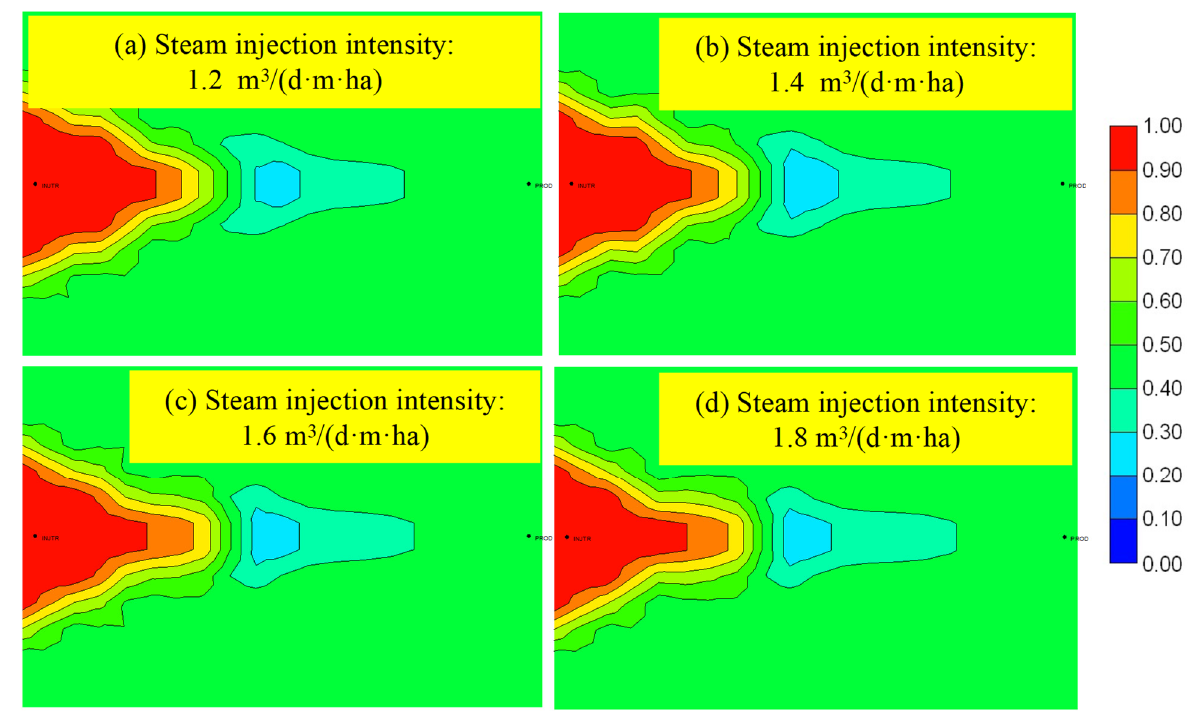
Figure 14. Mass fraction distribution of heavy component.